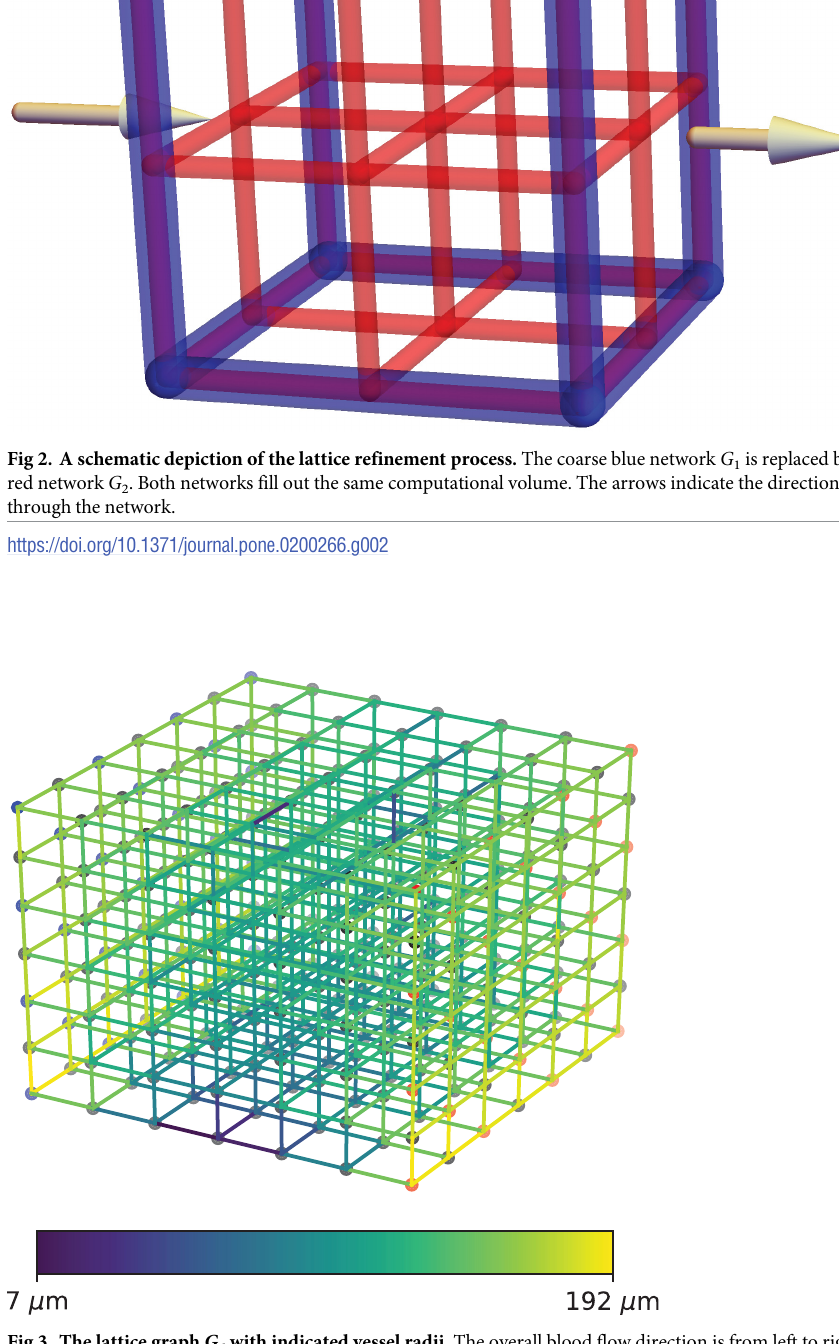
PLOS ONE | https://doi.org/10.1371/journal.pone.0200266 July 10,